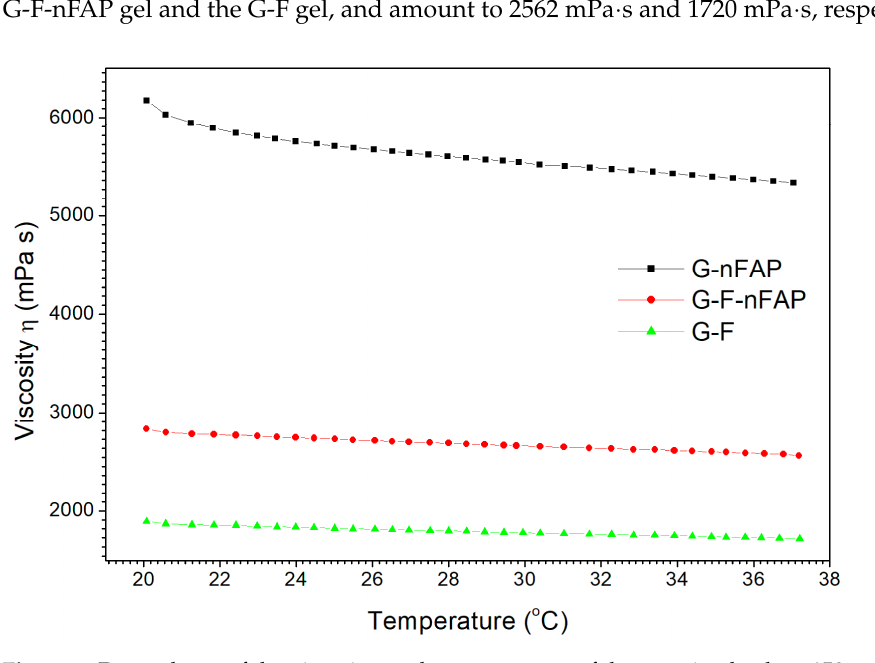
Figure 3. Dependence of the viscosity on the temperature of the examined gels at 150 s − 1 .